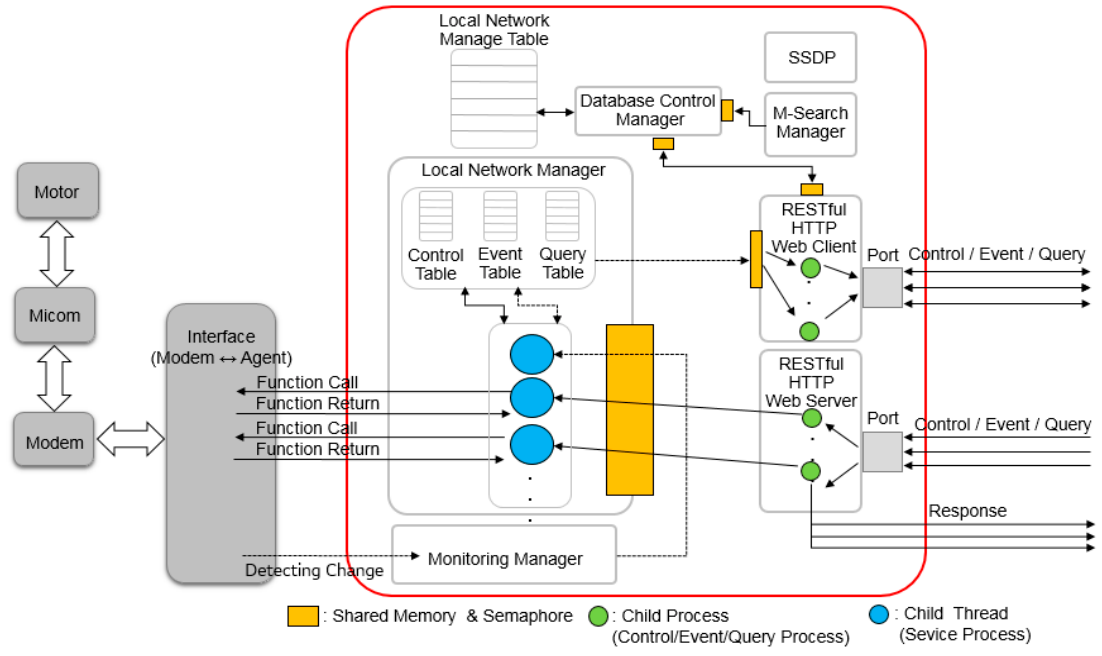
Figure 3. Typical appliance product for HALN architecture.